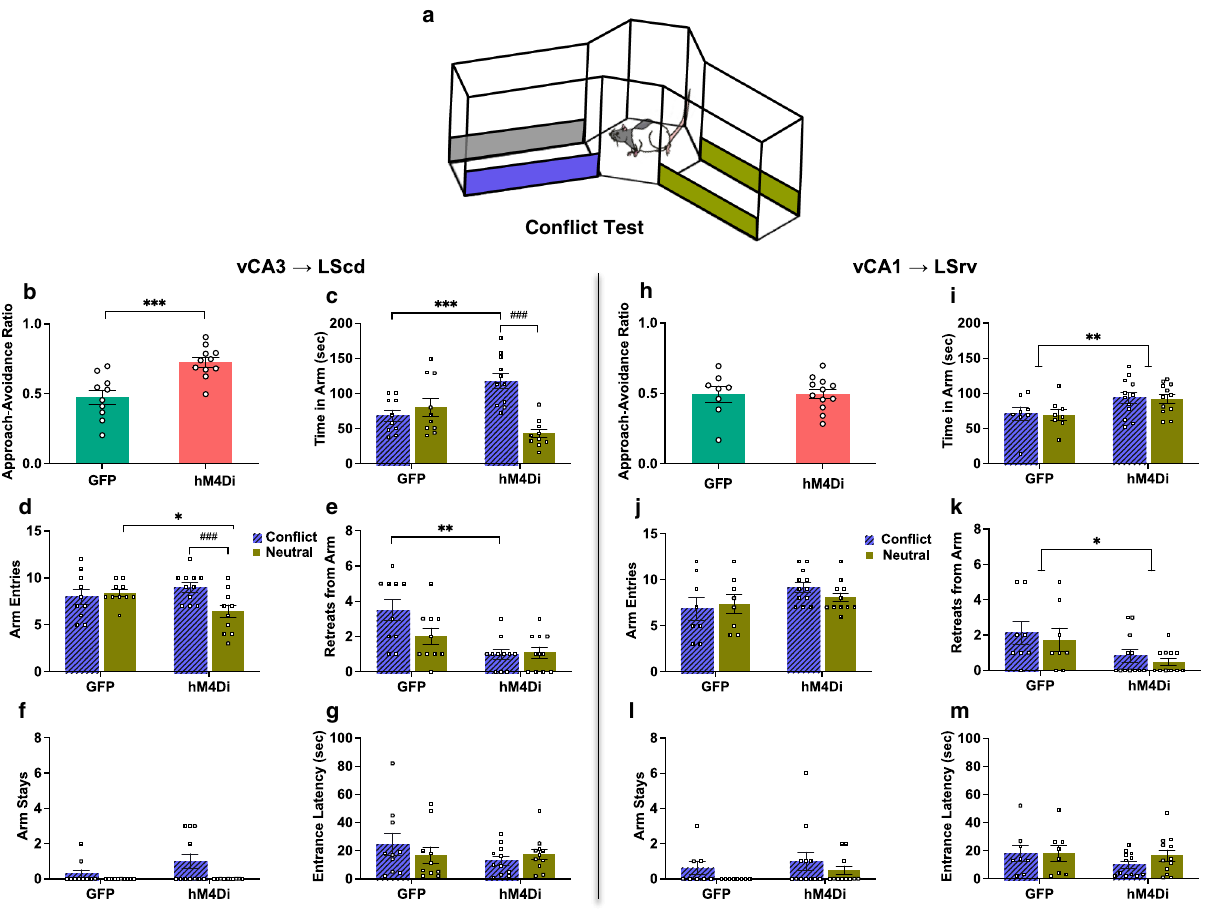
Fig. 3 vCA3 → LScd and vCA1 → LSrv circuit inhibition led to divergent responses during con fl ict test. a Schematic of con fl ict test con fi guration with grey and blue bars depicting the combined appetitive and aversive cues in one arm, and green bars representing the neural cues in another arm. b , c vCA3 → LScd hM4Di animals showed potentiated approach ( t 16.18 = 4.17, p = 0.0005) driven by spending more time in the con fl ict vs. neutral arm, and more con fl ict arm time than GFP controls (Arm x Virus: F (1,19) = 16.42, p = 0.0004; post hoc arm t 10 = 5.74, p = 0.0001; post hoc virus t 19 = 3.66, p = 0.0009) d vCA3 → LScd hM4Di animals made more entries into the con fl ict than neutral, and less neutral arm entries than controls (Arm x Virus: